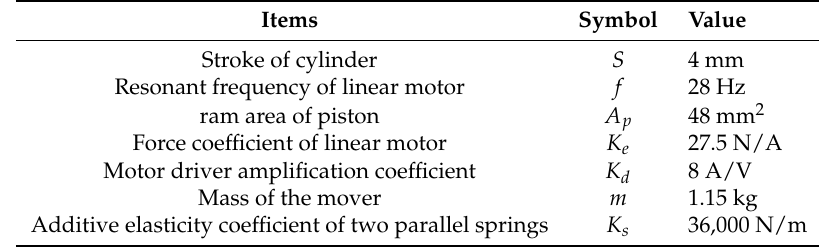
Figure 2. Experimental setup. Table 1. Key experimental parameters of test